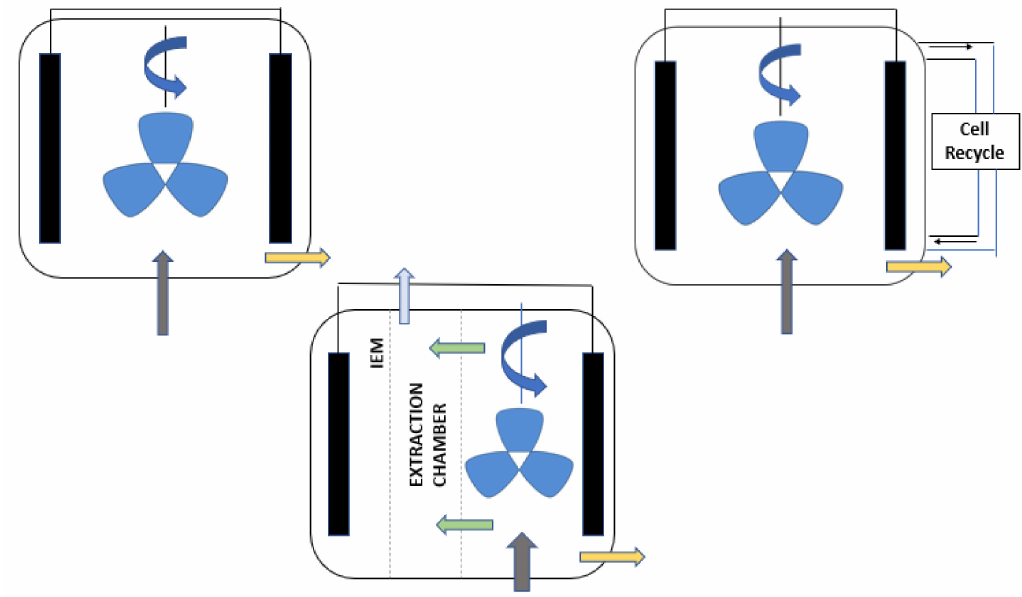
Figure 7. Diagrammatic representations of continuous stirred tank electro-fermenter